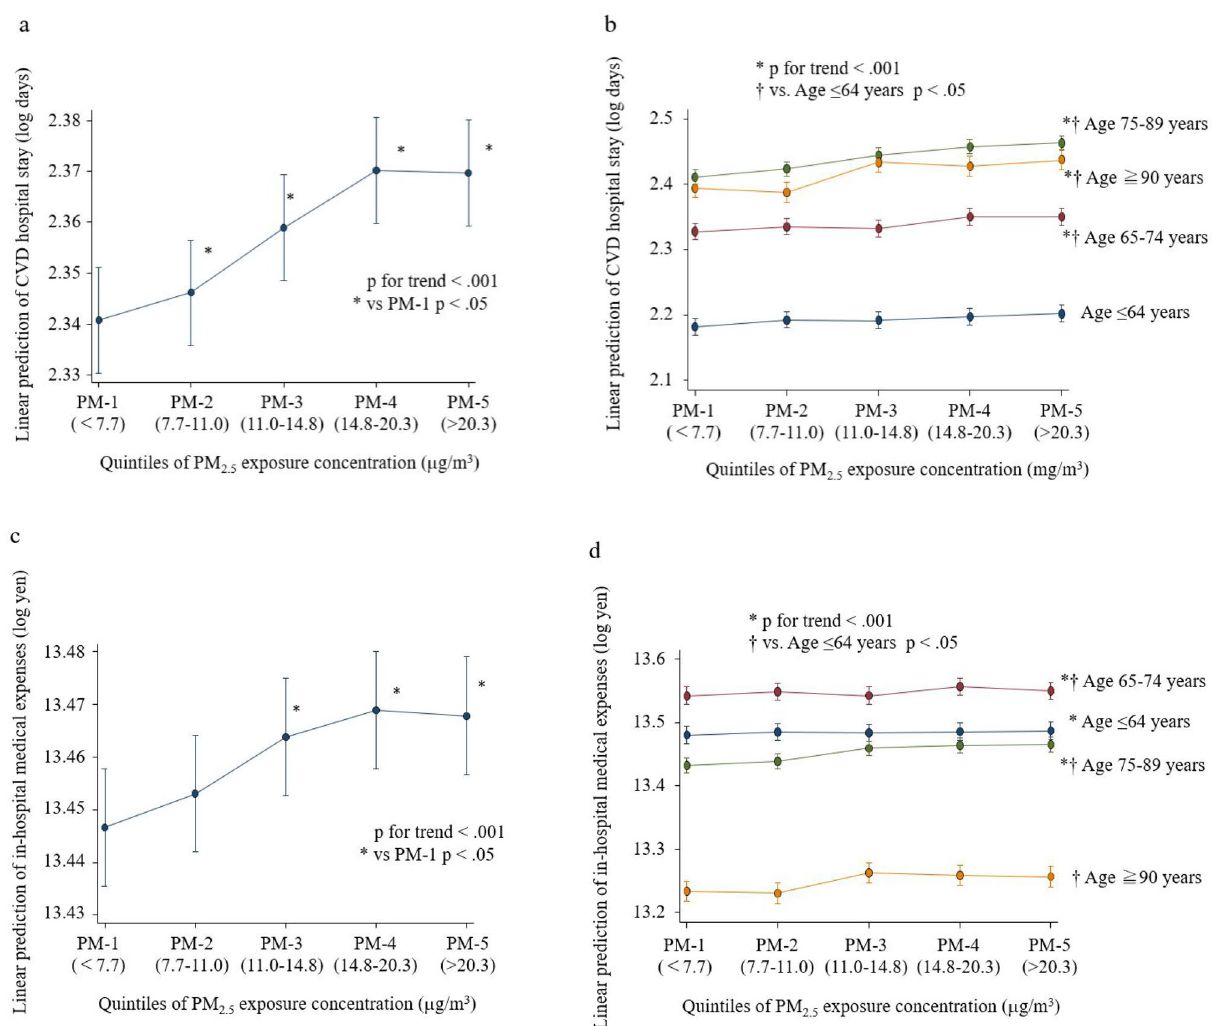
Figure 1. Relationship between PM 2.5 exposure and length of CVD-related hospital stays and in-hospital medical expenses. The predicted lengths of CVD-related hospital stays and in-hospital medical expenses were calculated using the “marginsplot” command in StataCorp 2015. Stata Statistical Software: Release 14 . College Station, TX: StataCorp LP., after the multilevel, mixed-effects, linear regression analyses were performed, as indicated in Tables 2 and 3. Error bars represent predictive margins with 95% confidence intervals. ( a ) The overall predicted length of hospital stays. ( b ) The predicted lengths of hospital stays per age group. ( c ) The overall predicted in-hospital medical expenses. ( d ) The predicted in-hospital medical expenses per age group. Each age group is indicated by a different colored line (≤ 64 years [blue], 65–74 years [red], 75–89 years [green], and ≧ 90 years [yellow]) in b and